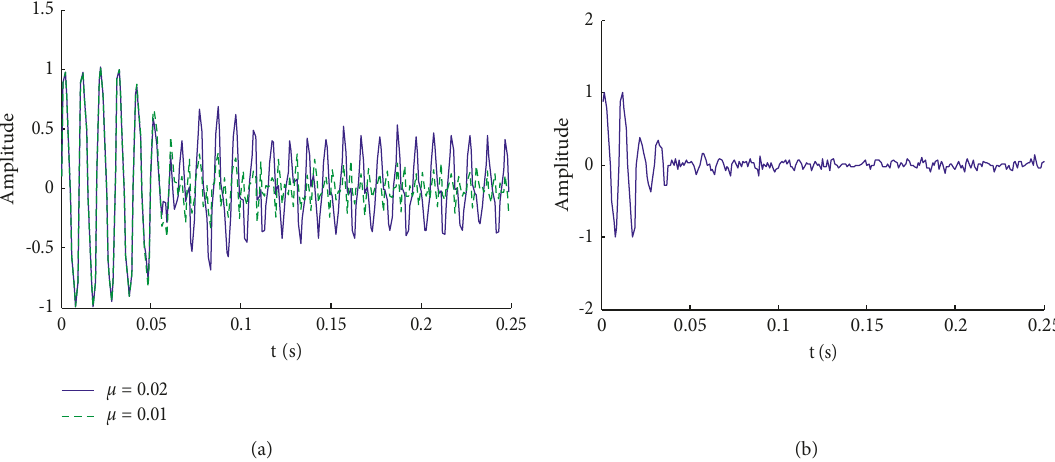
Figure 5: Curves of error signal time. (a) Fixed step-size algorithm. (b) Sinusoidal variable step-size algorithm.